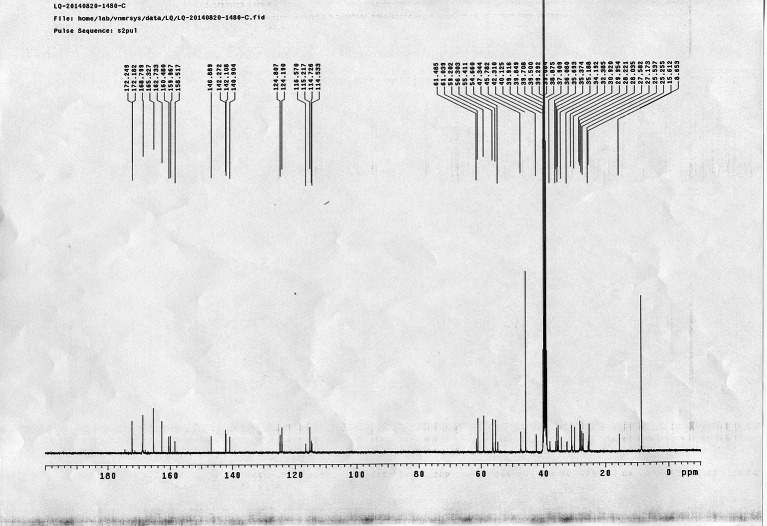
13C NMR spectra of bAL 1.